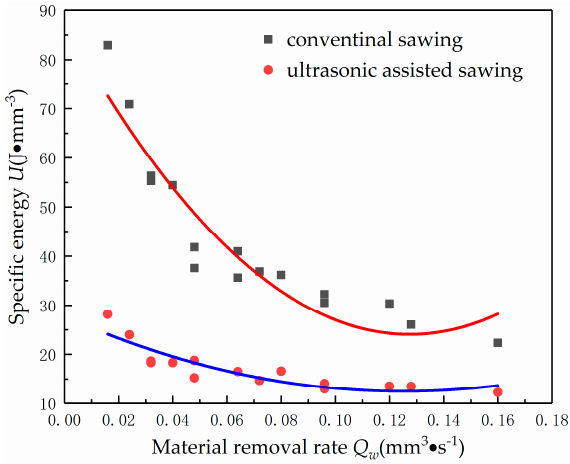
Figure 8. The specific energy U varying with material removal rate Q w.